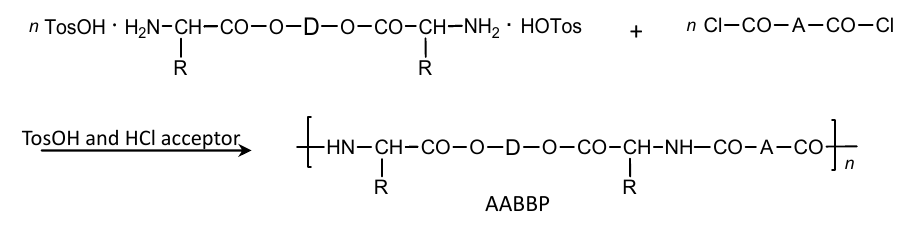
Figure 36. Synthesis of AABBP via interfacial polycondensation.